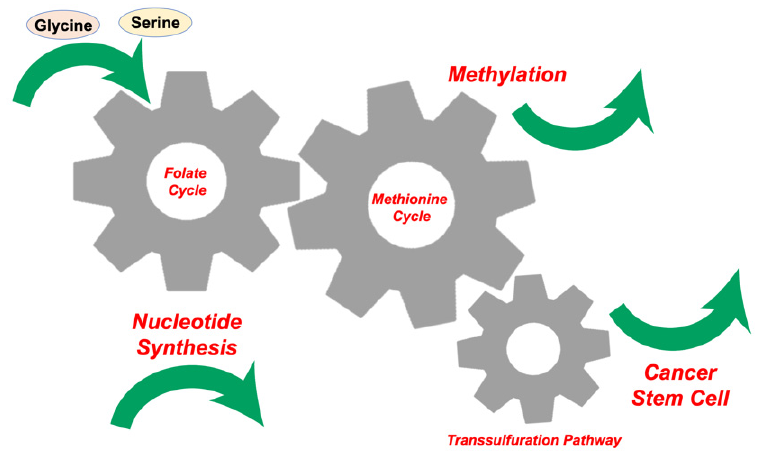
Figure 1. Inputs and outputs of one-carbon (1C) metabolism. The input amino acids, glucose, and metabolites fuel 1C metabolism, which generates various cellular outputs, such as nucleotide synthesis, methylation, and origination of cancer stem cells.